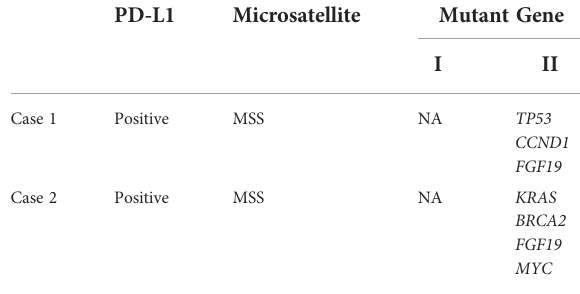
TABLE 1 The molecular background of two